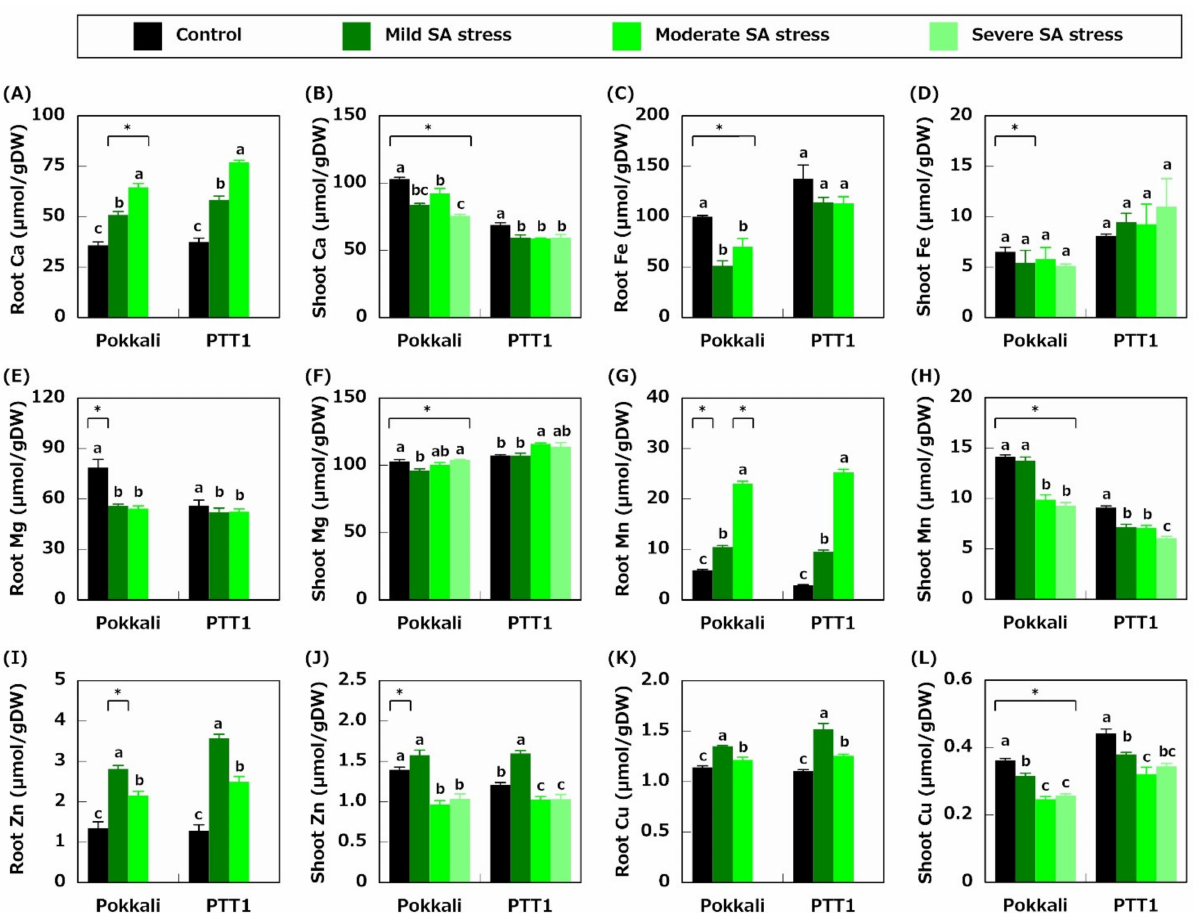
Figure 3. Effects of saline-alkaline stress (mild, moderate, and severe) on the Ca concentration of the roots ( A ) and shoots ( B ), Fe concentration of the roots ( C ) and shoots ( D ), Mg concentration of the roots ( E ) and shoots ( F ), Mn concentration of the roots ( G ) and shoots ( H ), Zn concentration of the roots ( I ) and shoots ( J ), and Cu concentration of the roots ( K ) and shoots ( L ) of Pokkali and PTT1. The concentration of each element in the roots of both rice varieties under severe SA conditions was not determined because of divalent metals deposition on the root surface. Similar letters indicate no significant differences between the treatments in each variety ( p < 0.05). Asterisks show significant differences between Pokkali and PTT1 in each treatment ( p <